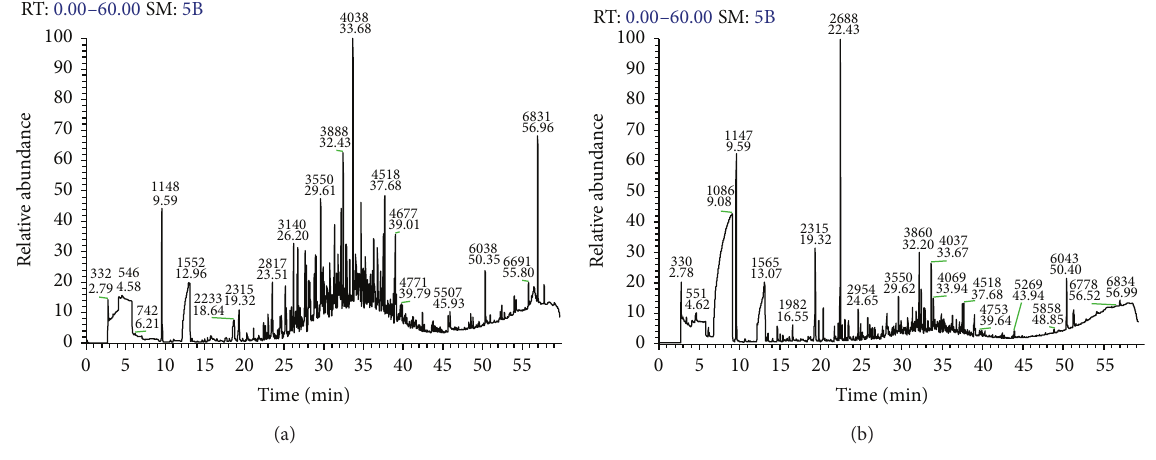
Figure 2: TIC chromatograms of an inlet (a) and outlet (b)